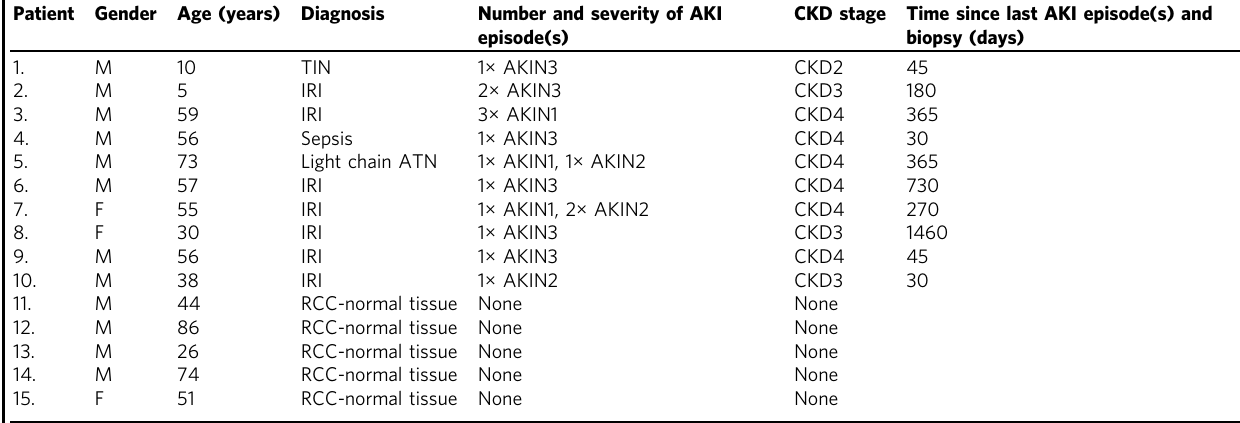
Table 1 List of patients with CKD after AKI analyzed in this study Patient Gender Age (years) Diagnosis Number and severity of AKI